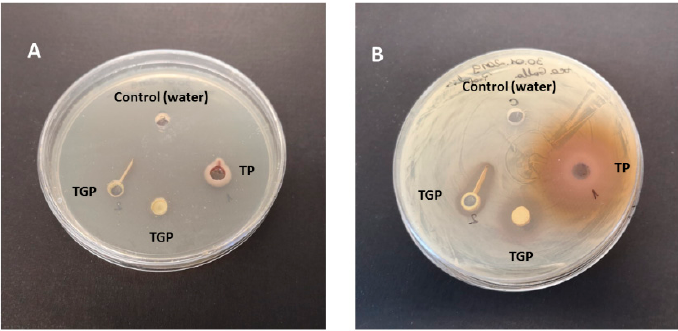
Figure 9. Inhibitory activity of TP and TGP extracts against S. epidermidis. ( A ): time 0; ( B ): after 24 h incubation.